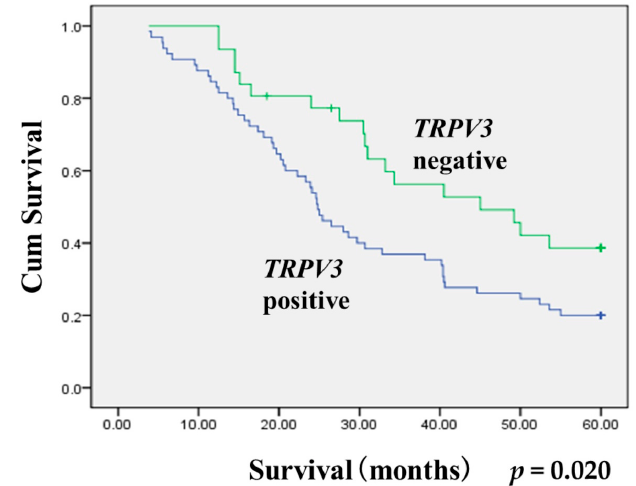
Figure 2. The Kaplan–Meier survival curves. Kaplan–Meier curves for cum survival rates according to TRPV3 expression status ( p = 0.020) in NSCLC. Statistical differences were calculated through log-rank comparisons.